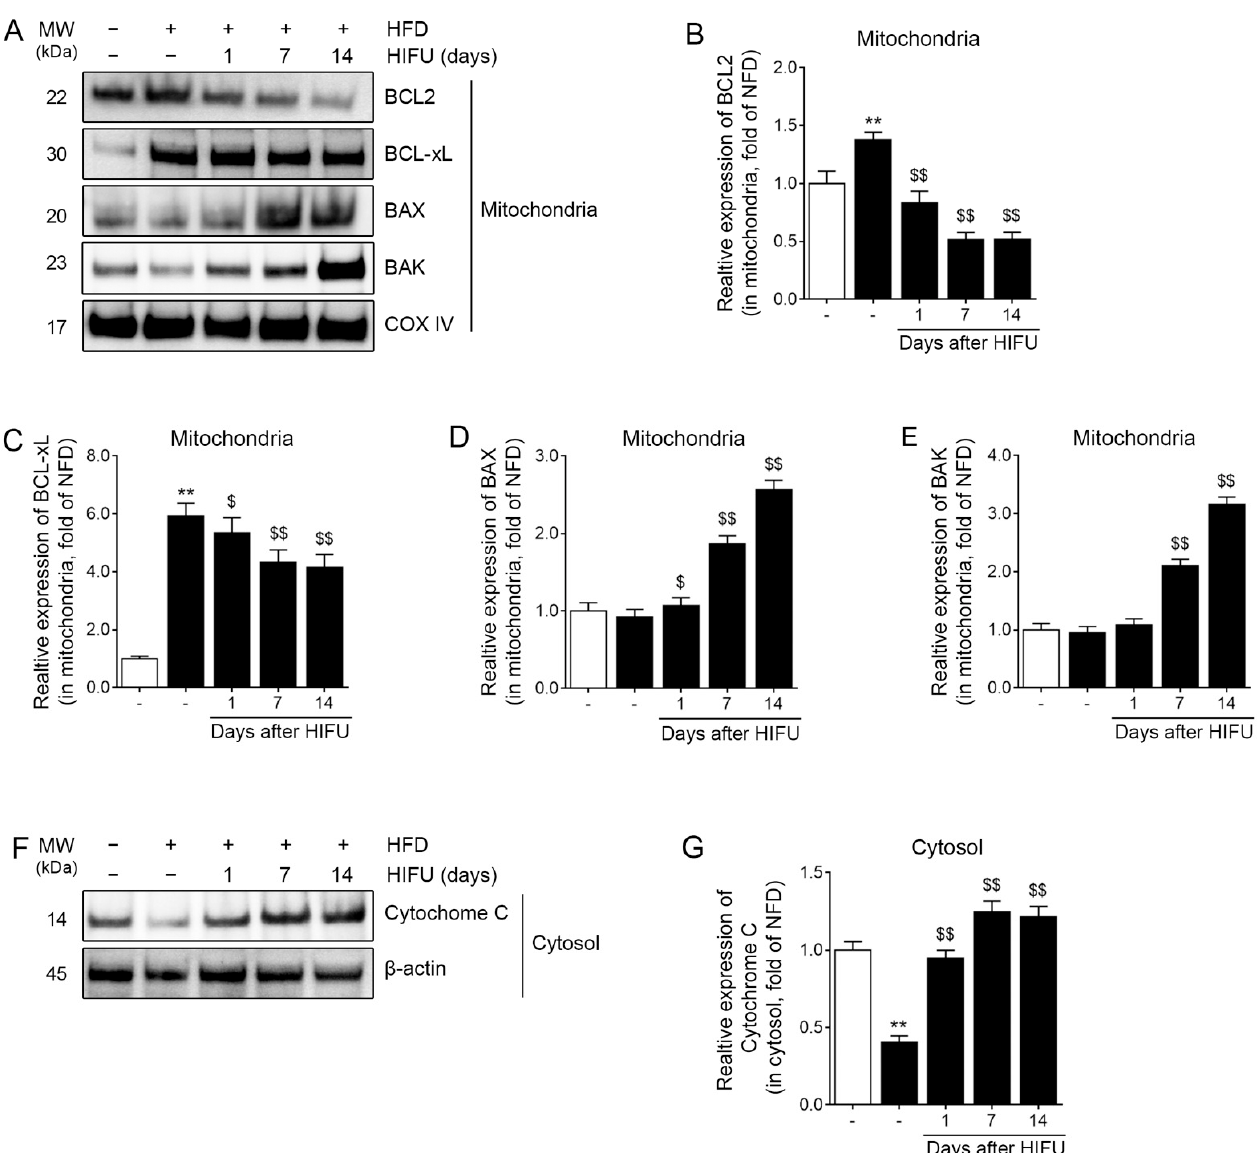
Figure 3. Regulation of the Bcl-2 family in SAT mitochondria and cytochrome C in SAT cytoplasm by HIFU treatment. ( A ) The protein expression levels of Bcl-2 family members were analyzed by western blot. ( B – E ) The quantitative graphs represent the results of the western blot analysis. The protein expression levels of BCL2 ( B ) and BCL-xL ( C ) were decreased by HIFU treatment. The protein expression levels of BAX ( D ) and BAK ( E ) were increased by HIFU treatment. ( F ) The protein expression of cytochrome C was analyzed by western blot. ( G ) The quantitative graphs represent the results of the western blot analysis. The protein expression of cytochrome C was increased by HIFU treatment. The data are presented as the mean ± standard deviation; **, p < 0.01 HFD vs. NFD; $, p < 0.05 or $$, p < 0.01 vs. HFD (Mann–Whitney U test). BAK, Bcl-2 homologous antagonist/killer; BAX, bcl-2-like protein 4; BCL2, B-cell lymphoma 2; BCL-xL, B-cell lymphoma-extra large; COX